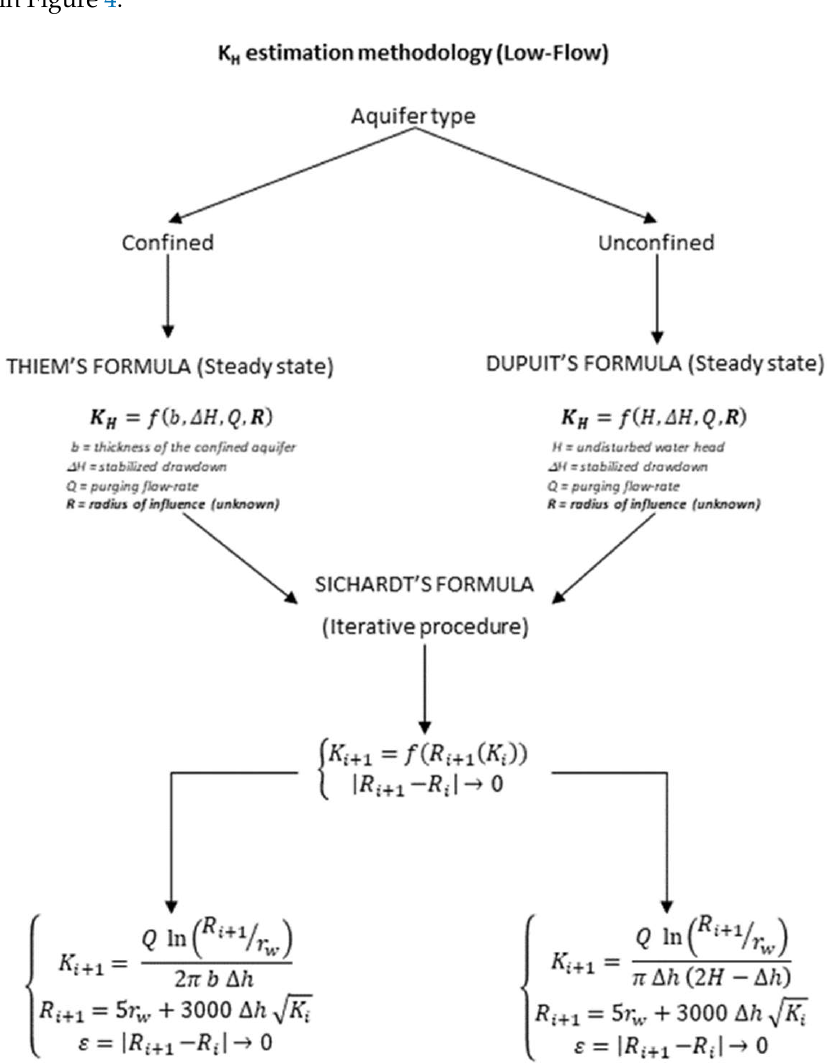
Figure 4. Flow-chart of the proposed methodology for K H estimation with low-flow purging. Vertical flows may be considered mostly null compared to the horizontal ones, so, more realistically, water can be assumed to move horizontally through the well screen length.